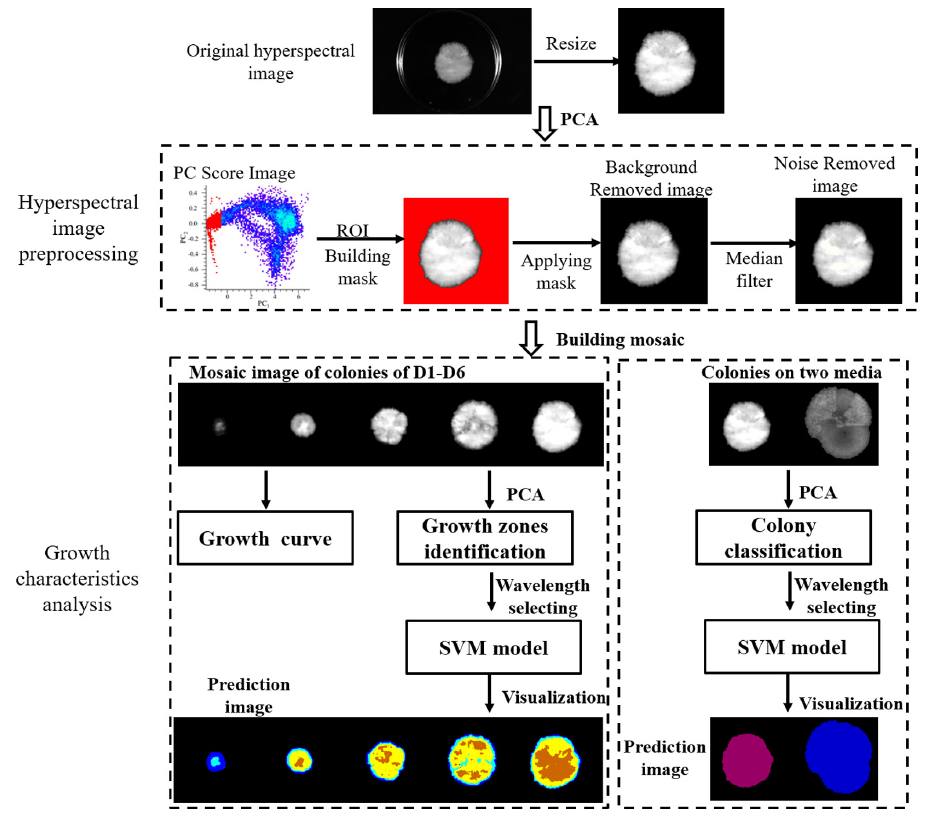
Fig. 1. Flowchart of data